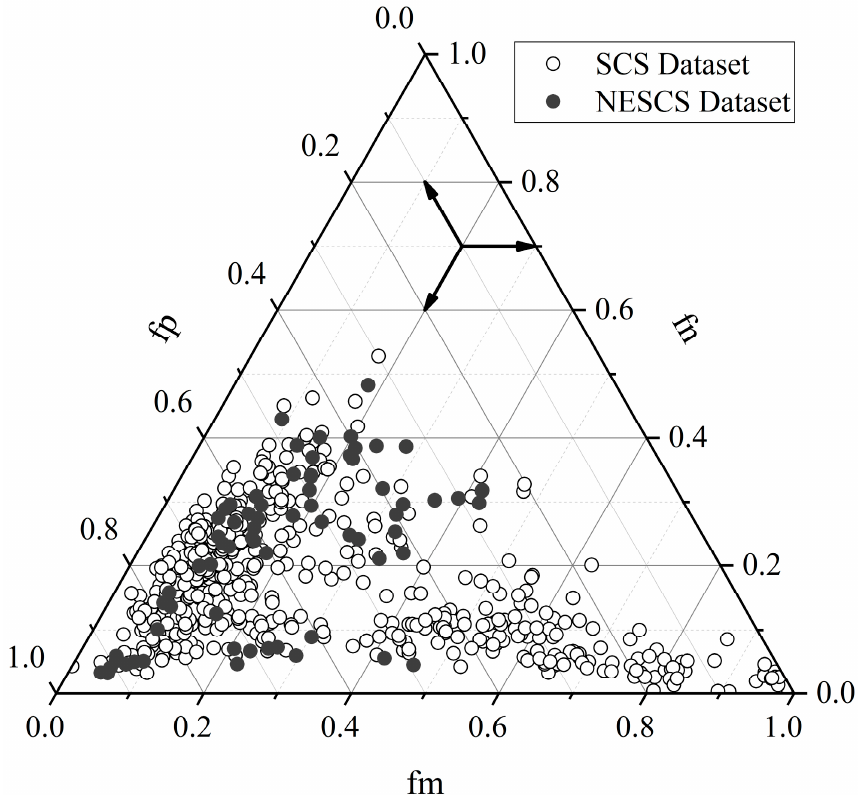
Figure 3. Ternary plots showing the fm, fn, and fp of SCS and NESCS